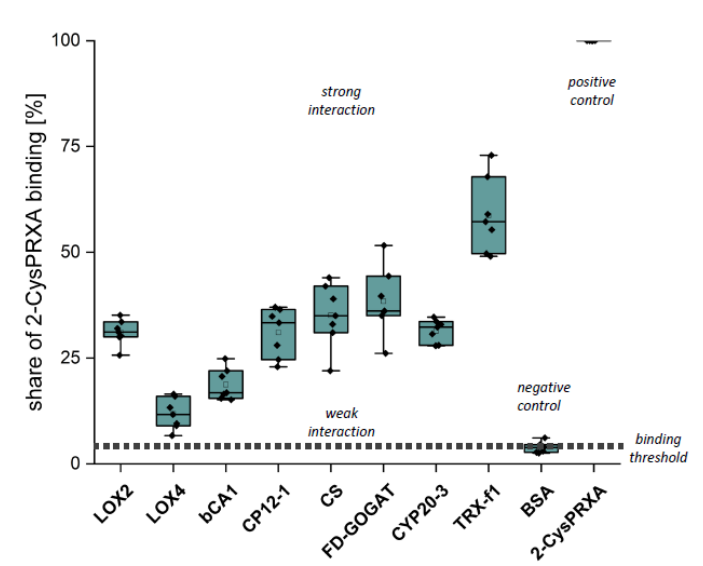
Figure 4. Binding of 2-CysPRX to recombinant polypeptides analyzed by Far Western blotting. Dilution series of recombinant proteins of β-CARBONICANHYDRASE (ßCA1), CHORISMATE SYNTHASE (CS), CHLOROPLAST REGULATOR (CP12-1), CYCLOPHILIN 20-3 (CYP20-3), FEREDOXIN-dependent GLUTAMINE-OXOGLUTARATE AMINOTRANSFERASE (FD-GOGAT), 13-LIPOXYGENASE (LOX2 and LOX4), and THIOREDOXIN-f1 (TRXf1). BOVINE SERUM ALBUMIN (BSA) served as negative and 2-CYSTEINE PEROXIREDOXIN (2-CysPRX) as positive control. The nitrocellulose membrane with